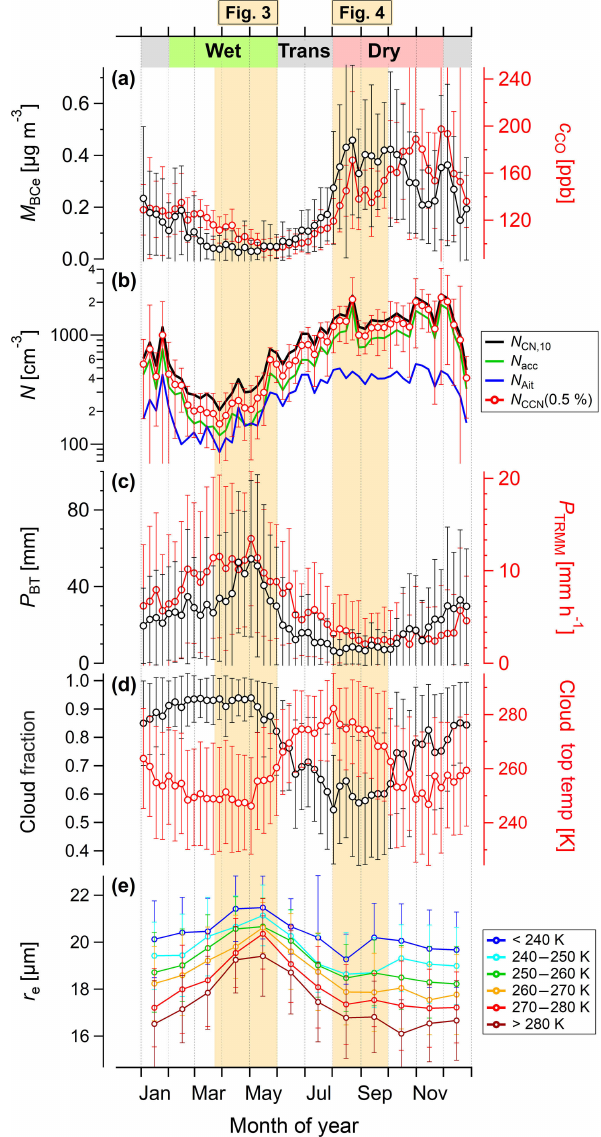
Figure 2. Seasonal cycle of selected trace gas, aerosol, and cloud microphysical parameters. (a) Pollution tracers, M BC and c CO . e (b) Total aerosol number concentration, N CN , 10 ; Aitken mode number concentration, N Ait ; accumulation mode concentration, N acc ; and CCN number concentration at S = 0 . 5%, N CCN (0.5%). (c) Precipitation products, P BT , representing cumulative pre- cipitation along BT tracks, and P TRMM , representing TRMM- derived precipitation within the ROI ATTO as defined in Fig. S1. (d) Satellite-derived cloud fraction and cloud top temperature within the ROI ATTO . (e) Satellite-derived cloud droplet effective ra- dius, r e , within the ROI ATTO . For a detailed characterization of the land use and recent land use change in the ATTO footprint, includ- ing the ROI ATTO , we refer to C. Pöhlker et al. (2018). Data in (a) to (d) are shown as weekly averages. Data in (e) are shown as monthly averages. Error bars represent 1 standard deviation. Vertical orange shading represents 2-month time in 2014 frames of representative clean and polluted conditions as shown in detail in Figs. 3 and